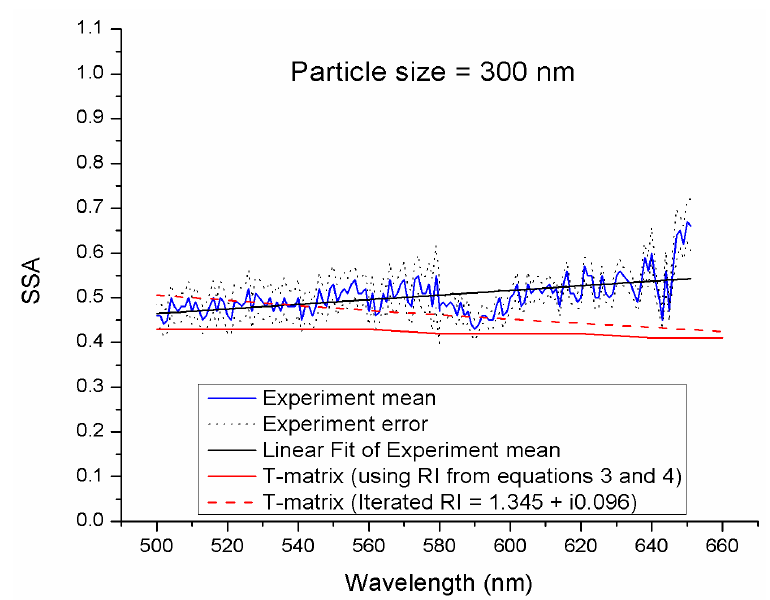
Figure 2. Comparison of experimental single scattering albedo (SSA) values and T-matrix calculated SSA values using the refractive index (RI) following Equations (3) and (4) and using RI = 1.34 + i0.096 to reproduce the experimental values for 300-nm particles collected in distilled water using an impinger.